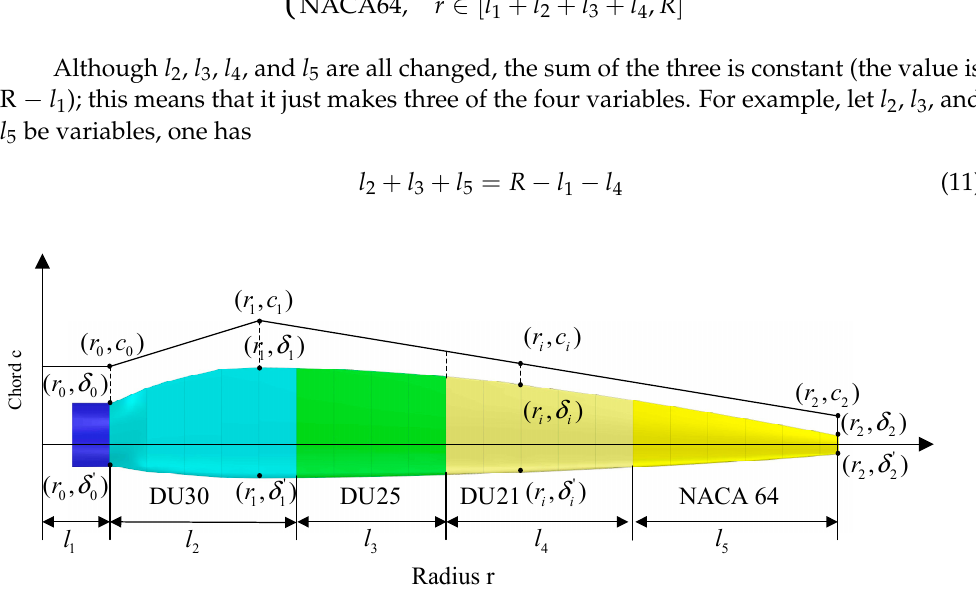
Figure 4. Blade airfoil distribution and chord length distribution.